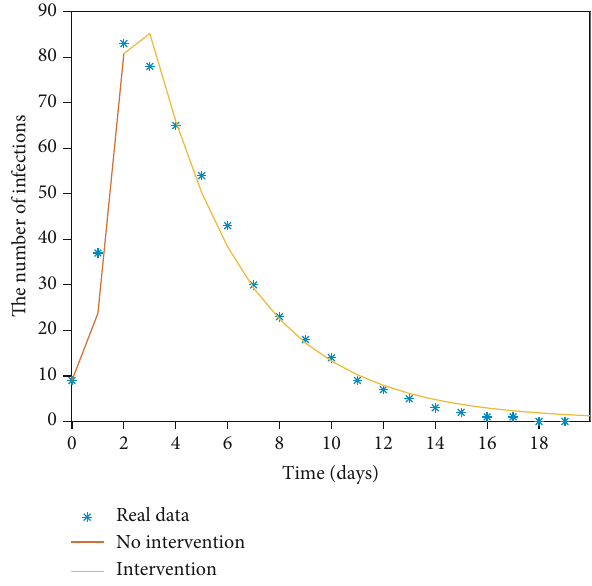
Figure 5: Quantity of the Norovirus infections I ð t Þ compared with the numerical results of the SEIAR model (52) obtained by MGAM method and g = 3 : 7399